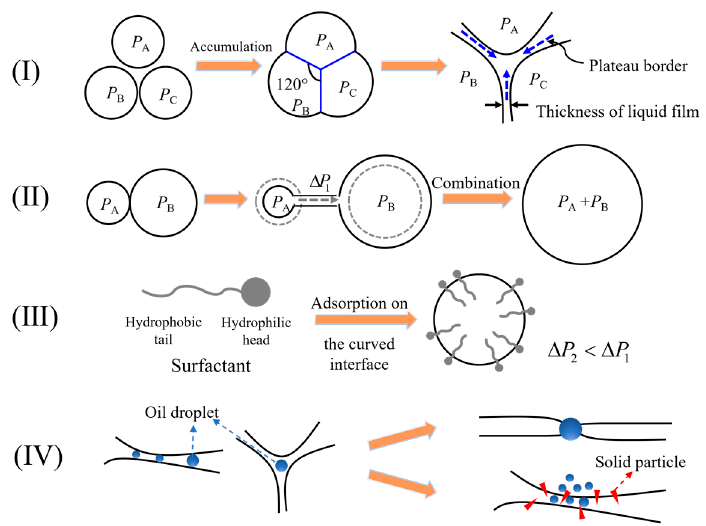
Figure 7. Foam evolution and the mechanism of defoamer in grouts.